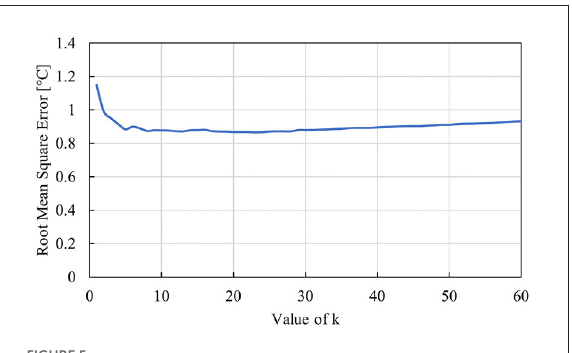
FIGURE5 Comparison of RMSE for various values of